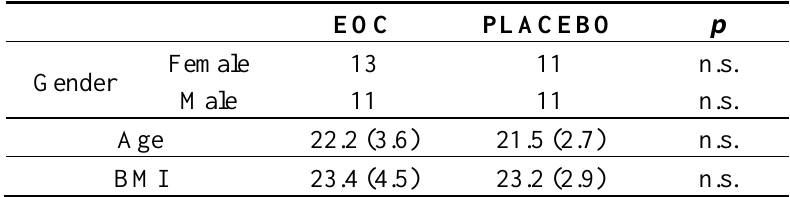
Table 1. Descriptive data for participants who consumed